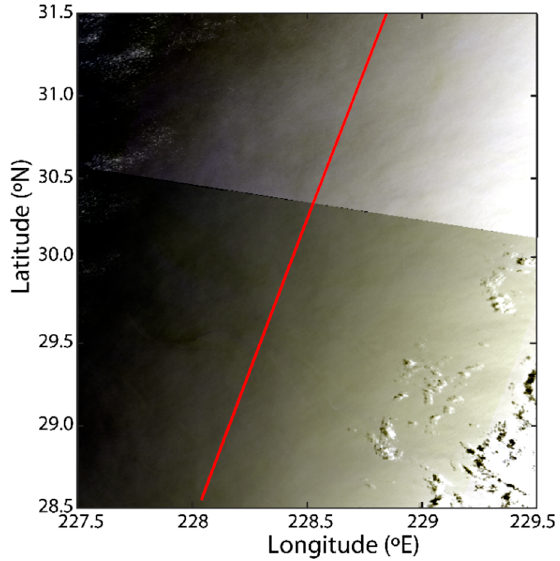
Figure 12. Sentinel-3A OLCI image dated 7 September 2018 from relative orbit 170 of cycle 033 showing no roughness distinct signatures along the altimeter satellite track (red line).